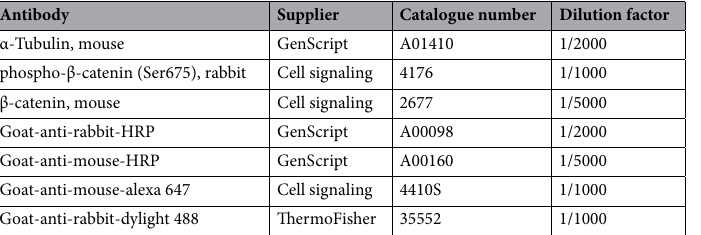
Table 2. Primary and secondary